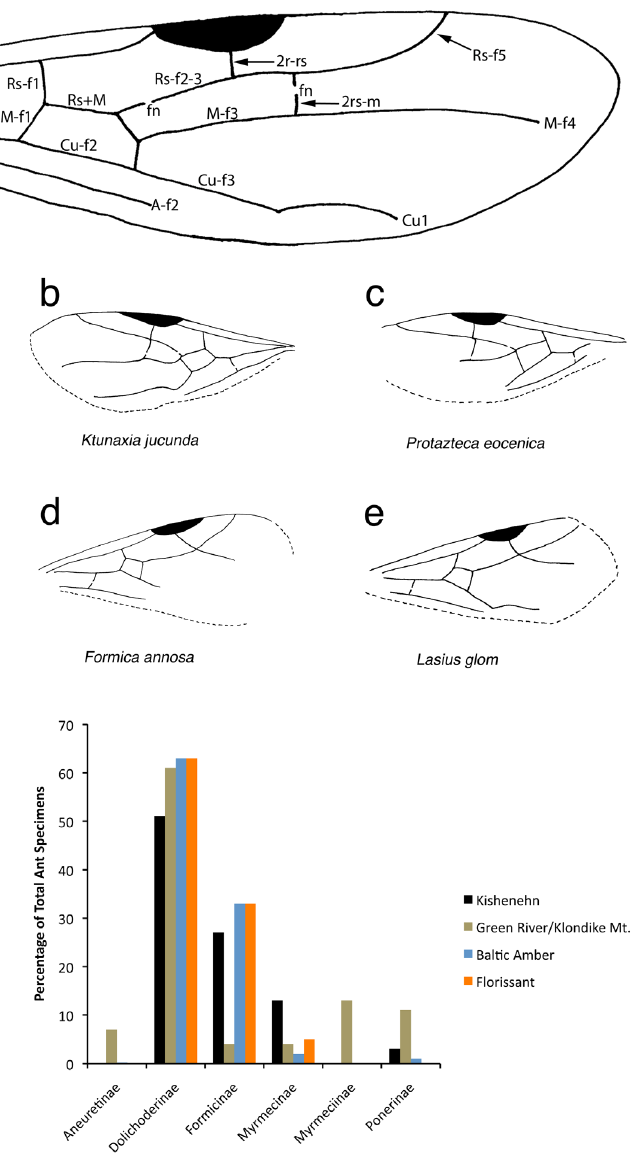
Fig 16 . Percentage of total ant fossils that are assigned to major subfamilies for four of the largest Eocene deposits that contain ant fossils.